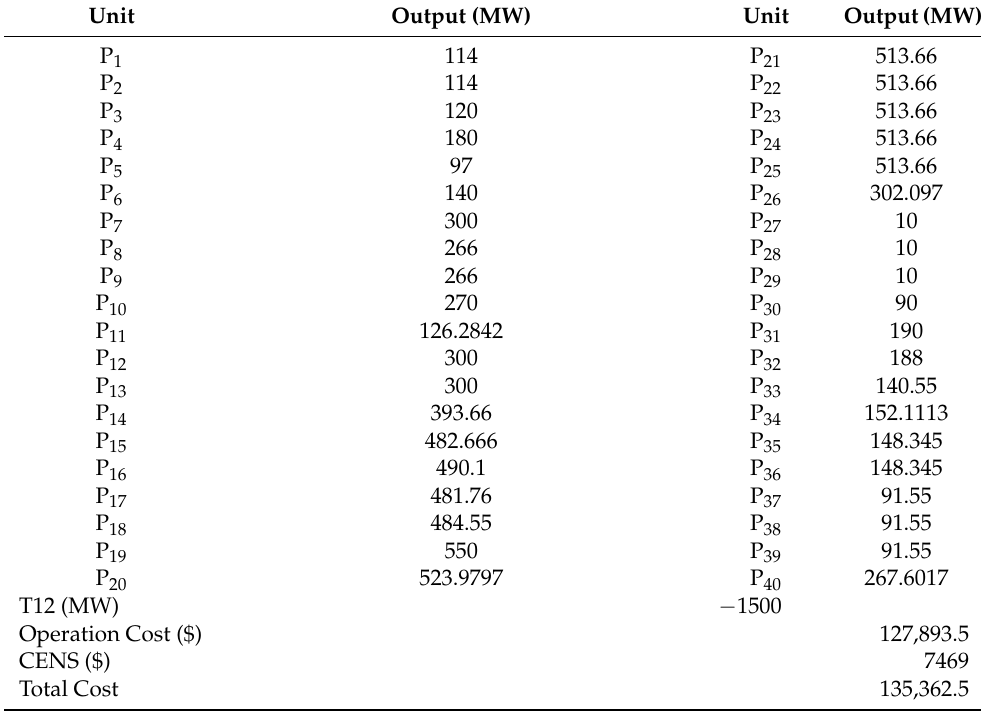
Table 7. The obtained values for the proposed reliability-oriented MAED problem for the large-scale test